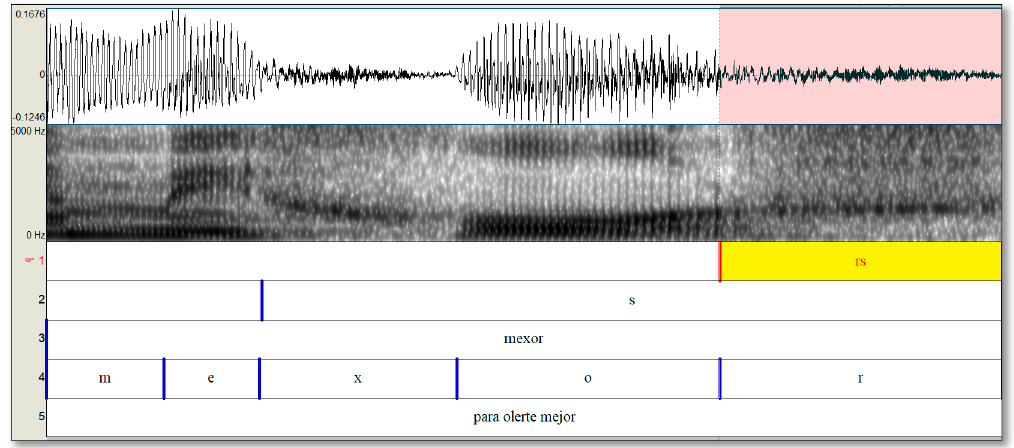
Figure 1. Transcription of the narrative in PraatAlign. Female speaker (UT007).